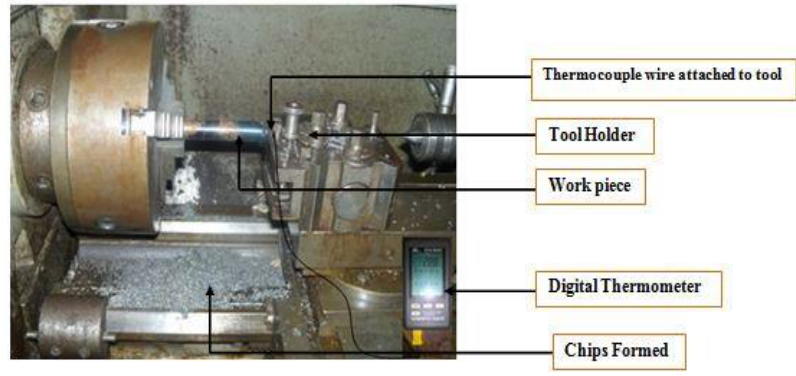
Figure 2: Experimental Set-up